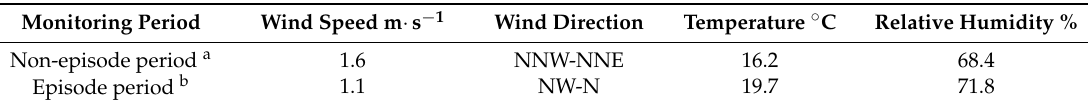
Table 1. Meteorological data for the corn straw open-field burning period and for the same period on the reference day.